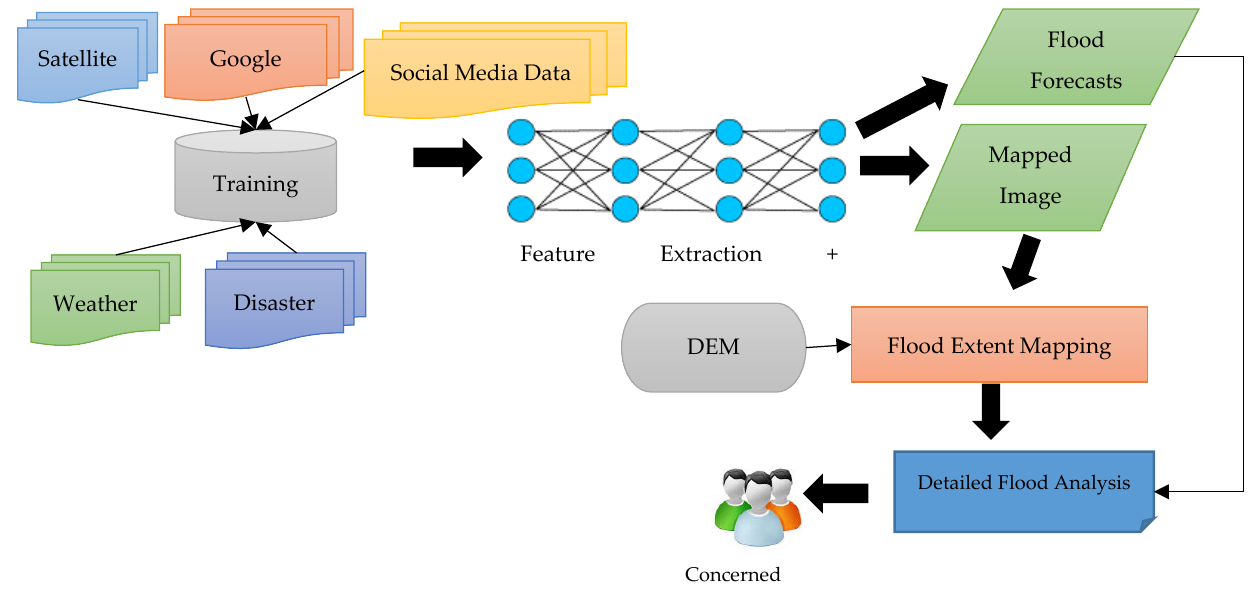
Figure 6. Schematic diagram of proposed system for flood detection and extent mapping .